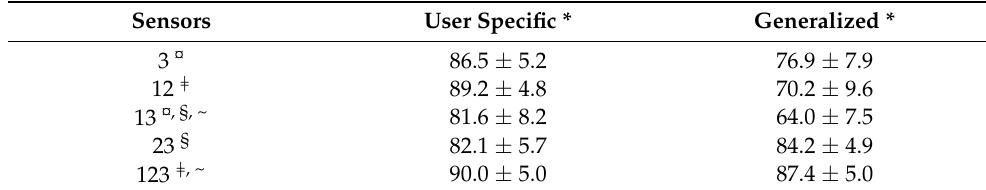
Table 5. Classification results for different sensor combinations when using the AP™ and additional sternum and/or upper leg sensors. Shown are mean accuracies (%) and the corresponding standard deviation of all seven subjects when developing user-specific or generalized models.